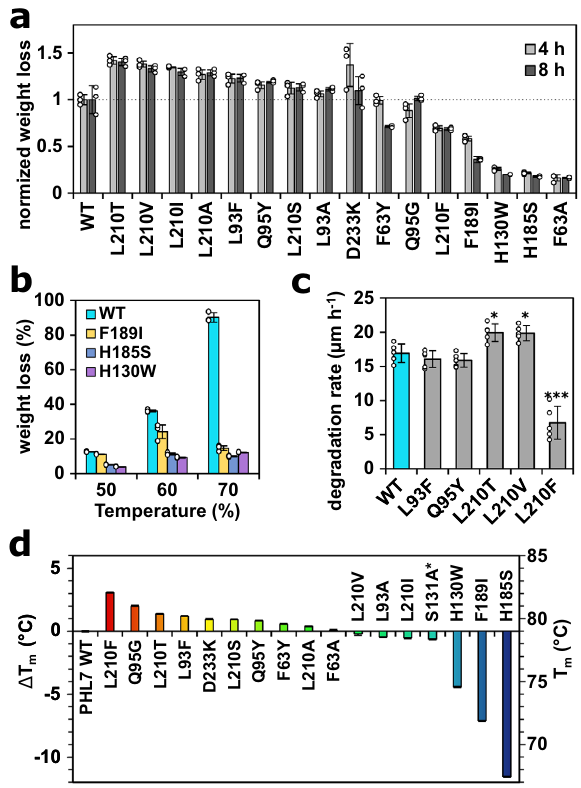
Fig. 3 | PET fi lm degradation and thermal stability of PHL7 variants. a PET fi lm weightlossafterreactiontimesof4hand8hat70°C,datanormalizedtoPHL7WT. b PET fi lm weight loss (in weight %, after 16h) of PHL7 WT compared to variants withreducedthermalstabilityatlowerreactiontemperatures. c AnalysisofPET fi lm thickness reduction between 10h to 15h of reaction by impedance spectroscopy ( n =5replicates). d Melting temperaturesof PHL7WTand itsvariants.The primary y-axisshowsthedifferenceinT m betweentheWTandvariants,thesecondaryy-axis depictstheabsolutemeltingtemperature.Ifnototherstated,meanvaluesfor n =3 replicates±SD are shown. * PHL7 variant S131A did not cause any PET weight loss after